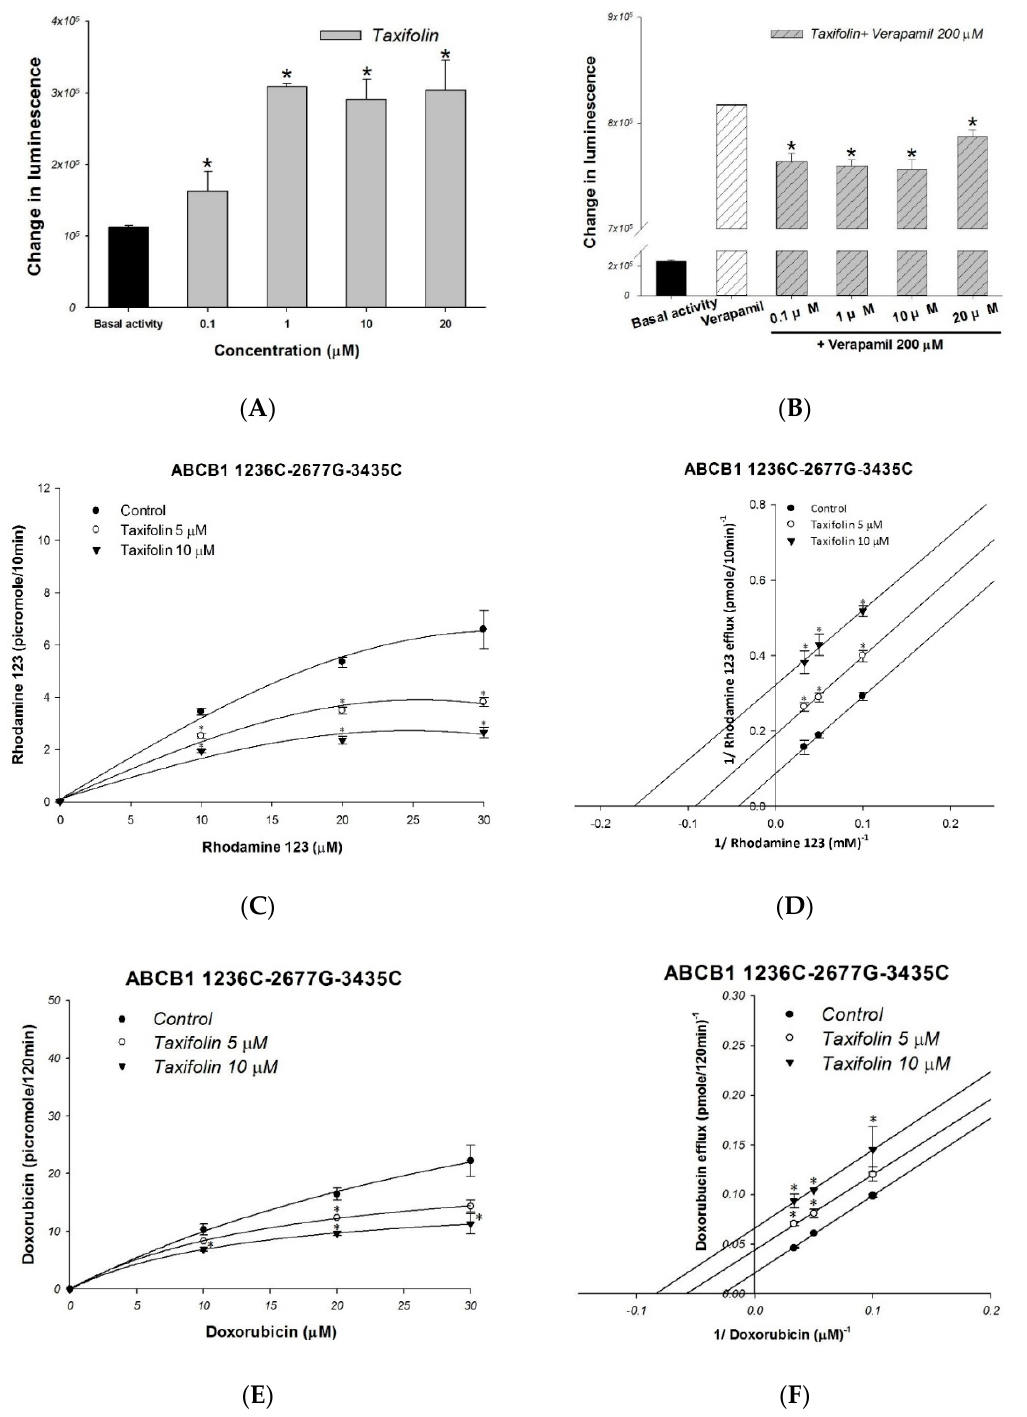
Figure 2. Analyses of the effect of taxifolin on P-gp ATPase activity and kinetic mechanisms of inhibition. P-gp ATPase activity was measured by Pgp-Glo TM Assay System and data were analyzed in terms of RLUs. ( A ) Incubation with taxifolin (0.1–20 µ M) increased the P-gp ATPase activity. ( B ) The verapamil-stimulated P-gp ATPase activity was decreased by taxifolin treatment. ( C – F ) P-gp inhibition kinetics analysis of taxifolin on rhodamine 123 efflux and doxorubicin efflux. The left panels show the dose-dependent effect of taxifolin on rhodamine 123 efflux ( C ) and doxorubicin efflux ( E ) followed the Michaelis–Menten kinetics, and the right panels demonstrate the Lineweaver − Burk plot analysis of rhodamine 123 efflux ( D ) and doxorubicin efflux ( F ). Data presented as mean ± SE of at least three experiments, each in triplicate. * denotes p < 0.05 as compared to untreated control in ( A , C – F ); In ( B ), * denotes p < 0.05 as compared to verapamil treated only.